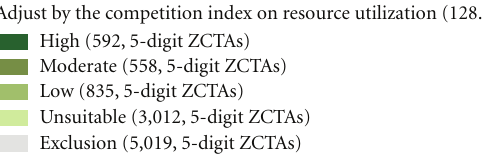
for the resource, organized at the 5-digit zip code